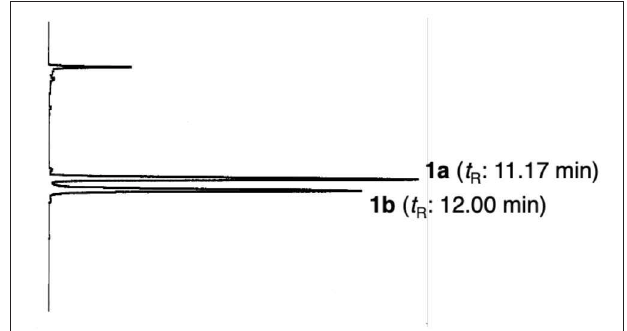
FIGURE 3 | HPLC chromatogram of kayeassamin I (1a, 1b) . HPLC condition: column, Cosmosil 5C 18 -MS-II (250 × 4.6mm, i.d.); detection, UV (254nm);